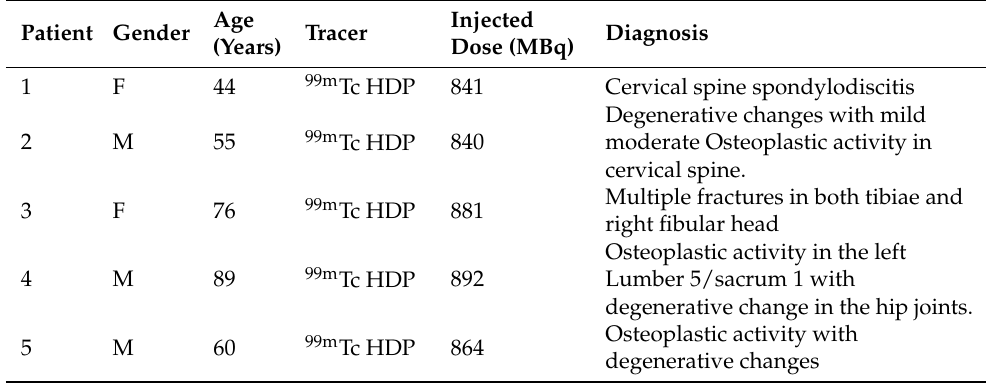
Table 1. Patients’